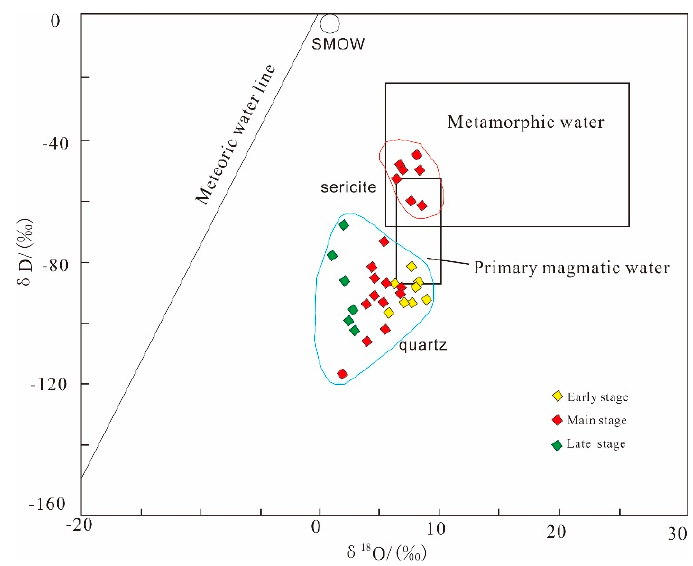
Figure 11. Isotopic compositions of oxygen and hydrogen in the Sanshandao gold deposit using data from Table 2. Blue circle and brown circles represent the data obtained from quartz and sericite, respectively.